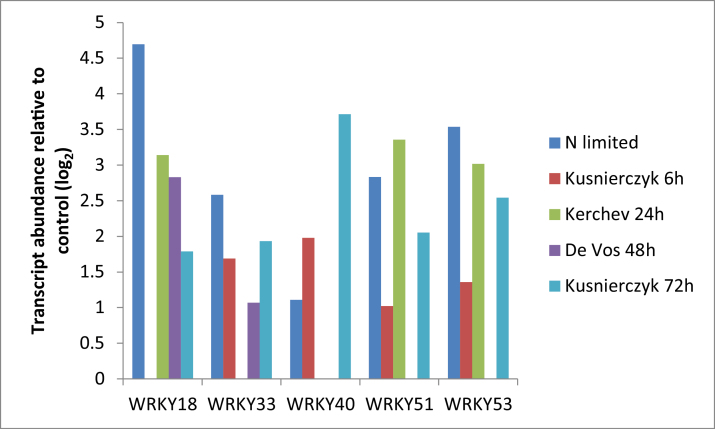
Expression of transcripts encoding WRKY transcription factors following N limitation in barley leaves or aphid infestation of Arabidopsis leaves. The expression level of transcripts encoding WRKY18 (mloc70190, At4g31800), WRKY33 (ak376482, At2g38470), WRKY40 (mloc 60890, At1g80840), WRKY51 (mloc 81131, At5g64810) and WRKY53 (ak369804, At4g23810) relative to N-replete or aphid-free controls, respectively, are indicated on a log2 scale. Aphid data refers to Brevicoryne brassicae infestation of ecotype Landsberg erecta for 6h (Kusnierczyk 6h), Myzus persicae infestation of ecotype Columbia for 24 or 48h (Kerchev 24h, De Vos 48h) or B. brassicae infestation of ecotype Columbia for 72h (Kusnierczyk 72h). Transcript data following aphid infestation was obtained fromKusnierczyk et al. (2008,2011), Kerchev et al. (2013) and De Vos et al. (2005).